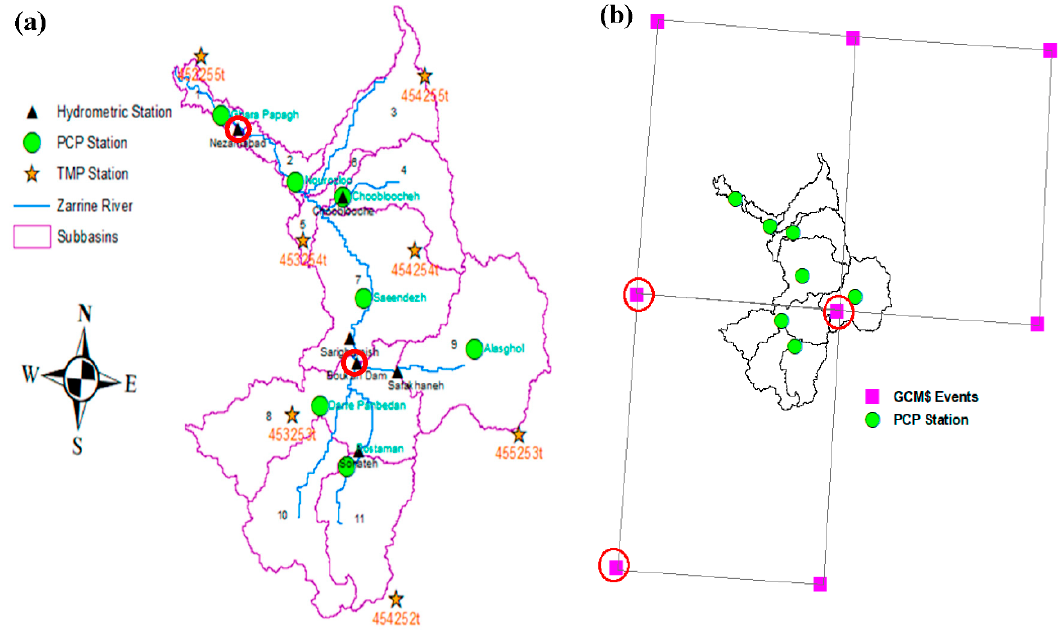
Figure 3. ( a ) map of selected weather and hydrometric stations in the ZRB-SWAT model (precipitation (PCP) and temperature (TMP); ( b ) selected GCM- points and -gridbox of MPI-ESM-LR. (PCP) and temperature (TMP); ( b ) selected GCM- points and -gridbox of